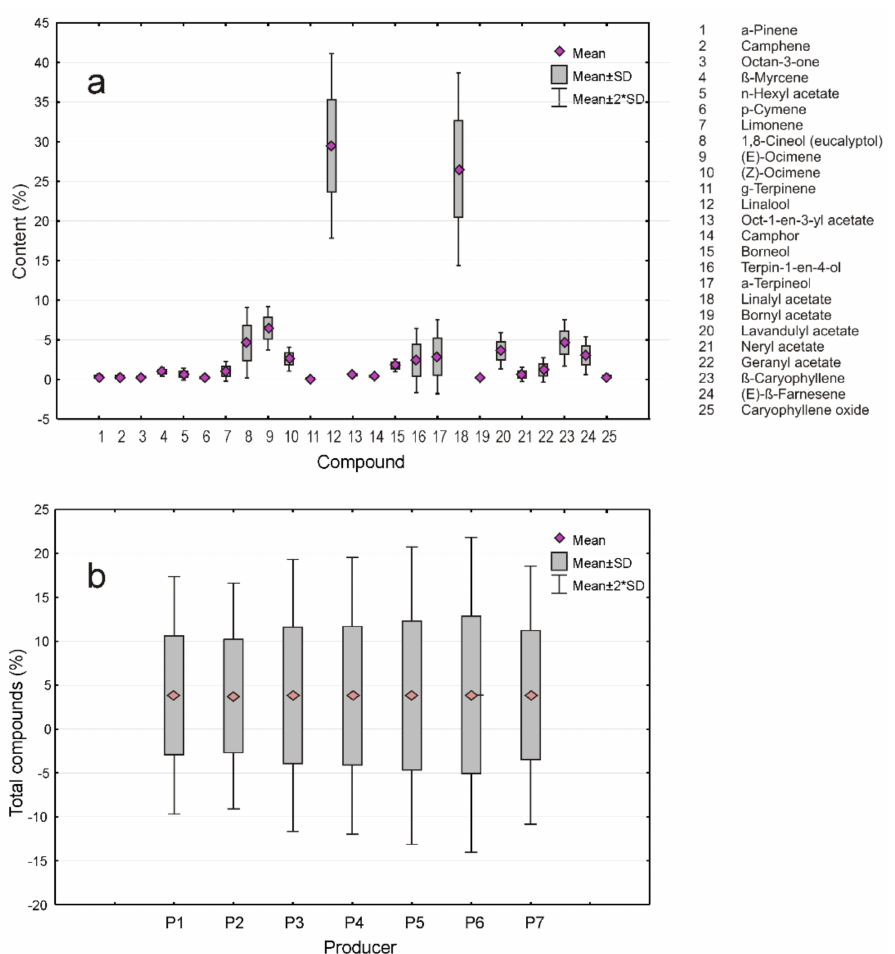
Figure 1. Box plots representing the distribution of ( a ) 25 components of lavender oil and ( b ) total content of compounds present in all the samples